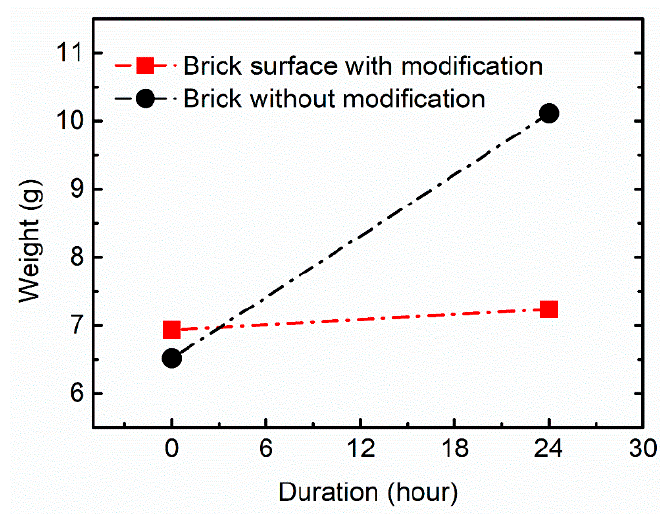
Figure 9. Comparison of weight increment between the bricks w / o surface modification immersed in water.